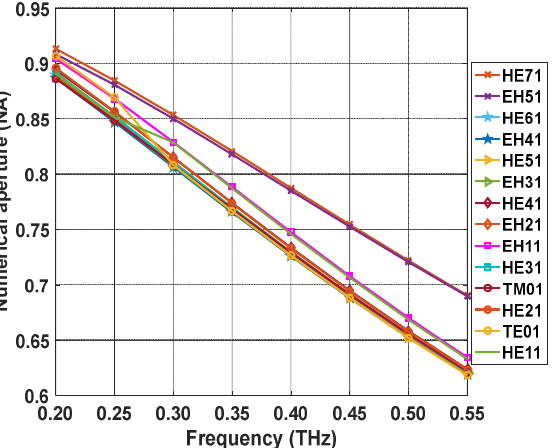
13 of 16 Figure 10. Effective mode area as a function of frequency for different modes. The numerical aperture is also known as the optical acquisition area, and the ability of the receiving end to collect light beam completely depends on the size of numerical aperture. The high numerical aperture can be obtained by increasing the effective mode area of the optical fiber. The numerical aperture of the optical fiber can be given as [25,26]: